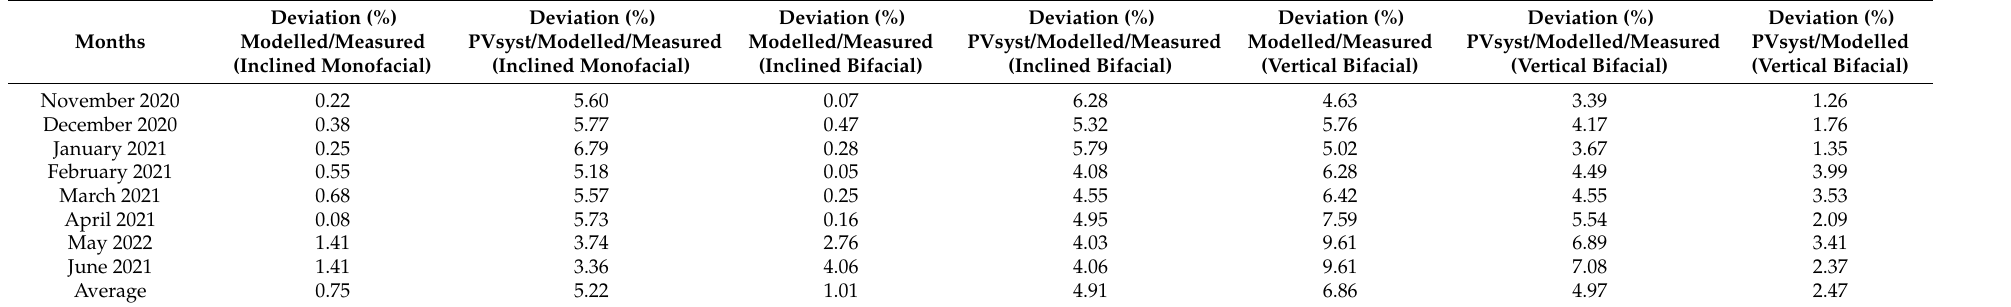
Table 5. Monthly potential energy yield deviation (November 2020–June 2021 field data).